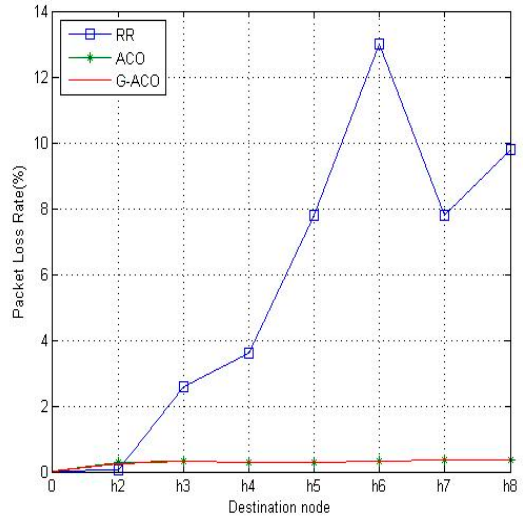
Figure 8. The comparison of packet loss rates.